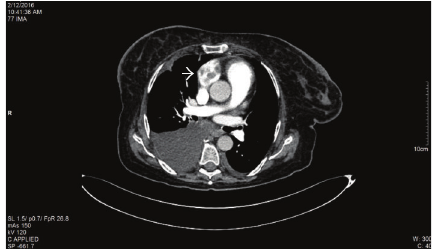
Figure 3: Contrast-enhanced CT scan. The white arrow shows multiple thrombi in the left